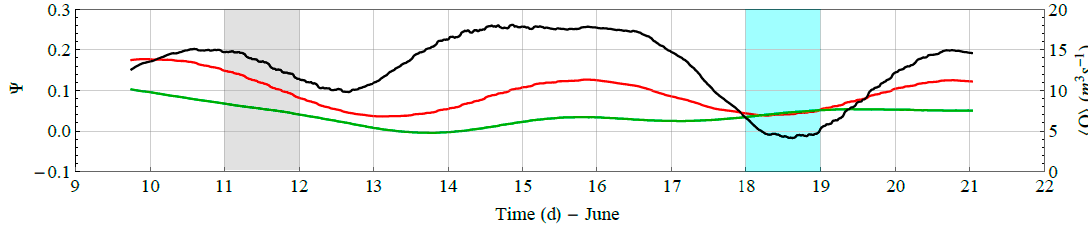
Figure 6. Discharge asymmetry index (black line). Temporal variations of subtidal discharges in the eastern (red line) and western branch (green line). The grey and blue highlighted boxes represent the spring and neap tide, respectively.